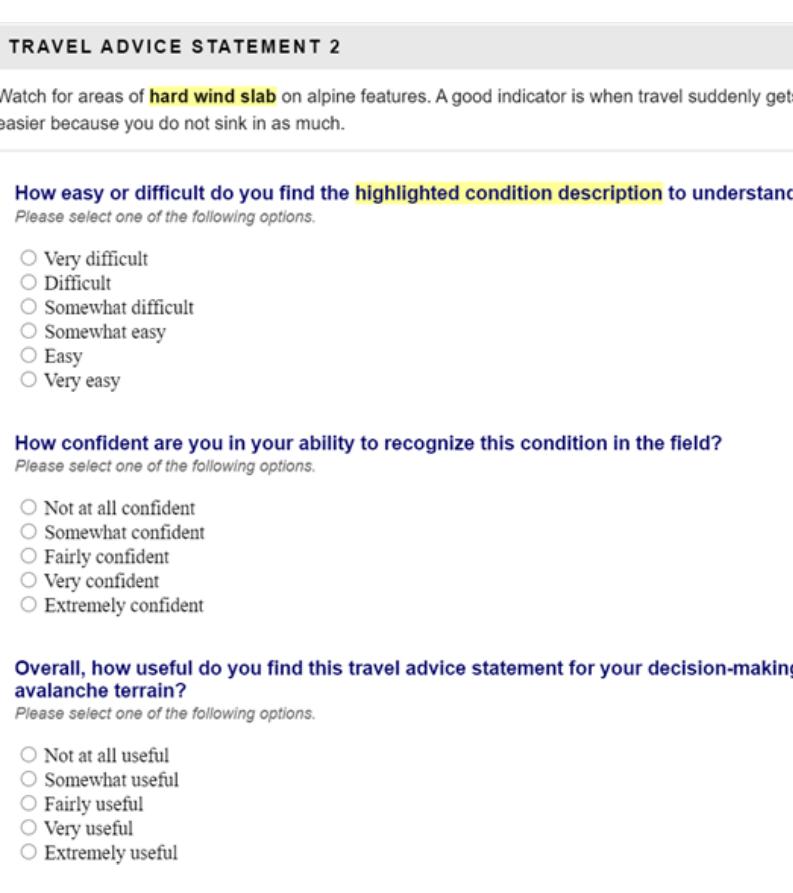
Figure 1. Screenshot of the survey question for the example